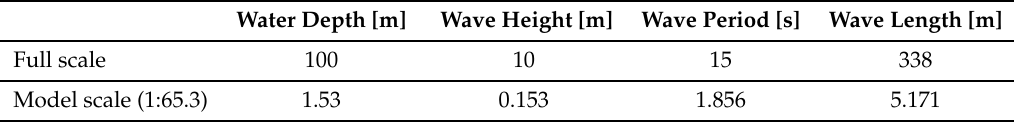
Table 3. Regular wave parameters for model-scale and full-scale models.